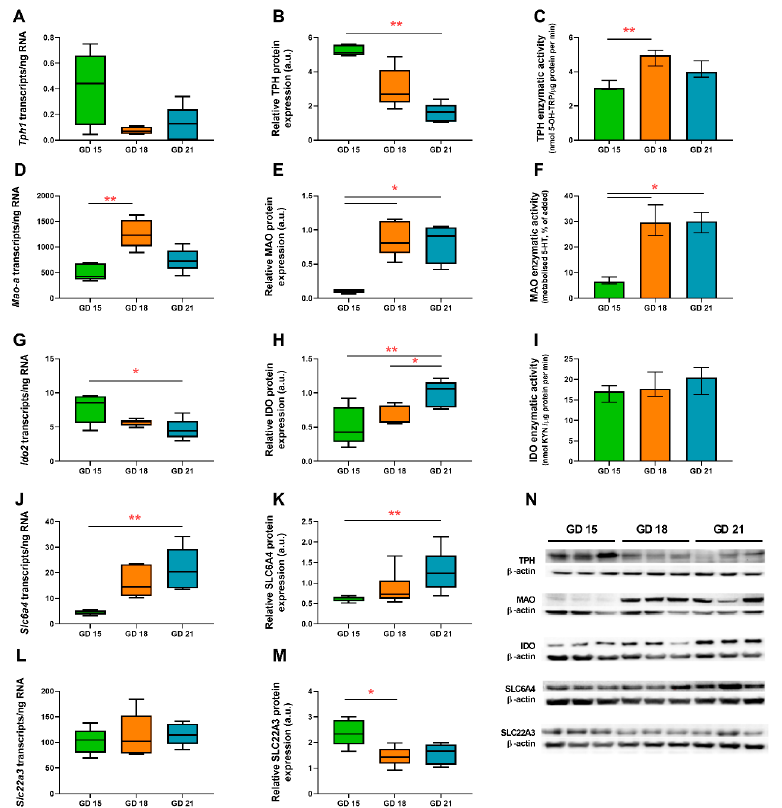
Figure 3. Expression and functional analysis of the rate-limiting enzymes: Tph1 / tryptophan hydroxylase (TPH) ( A – C ), Mao-a / monoamine oxidase (MAO) ( D – F ), Ido2 / indoleamine 2,3-dioxygenase (IDO) ( G – I ), and key transporters— Slc6a4 / SLC6A4 ( J , K ) and Slc22a3 / SLC22A3 ( L , M )—of the TRP metabolic